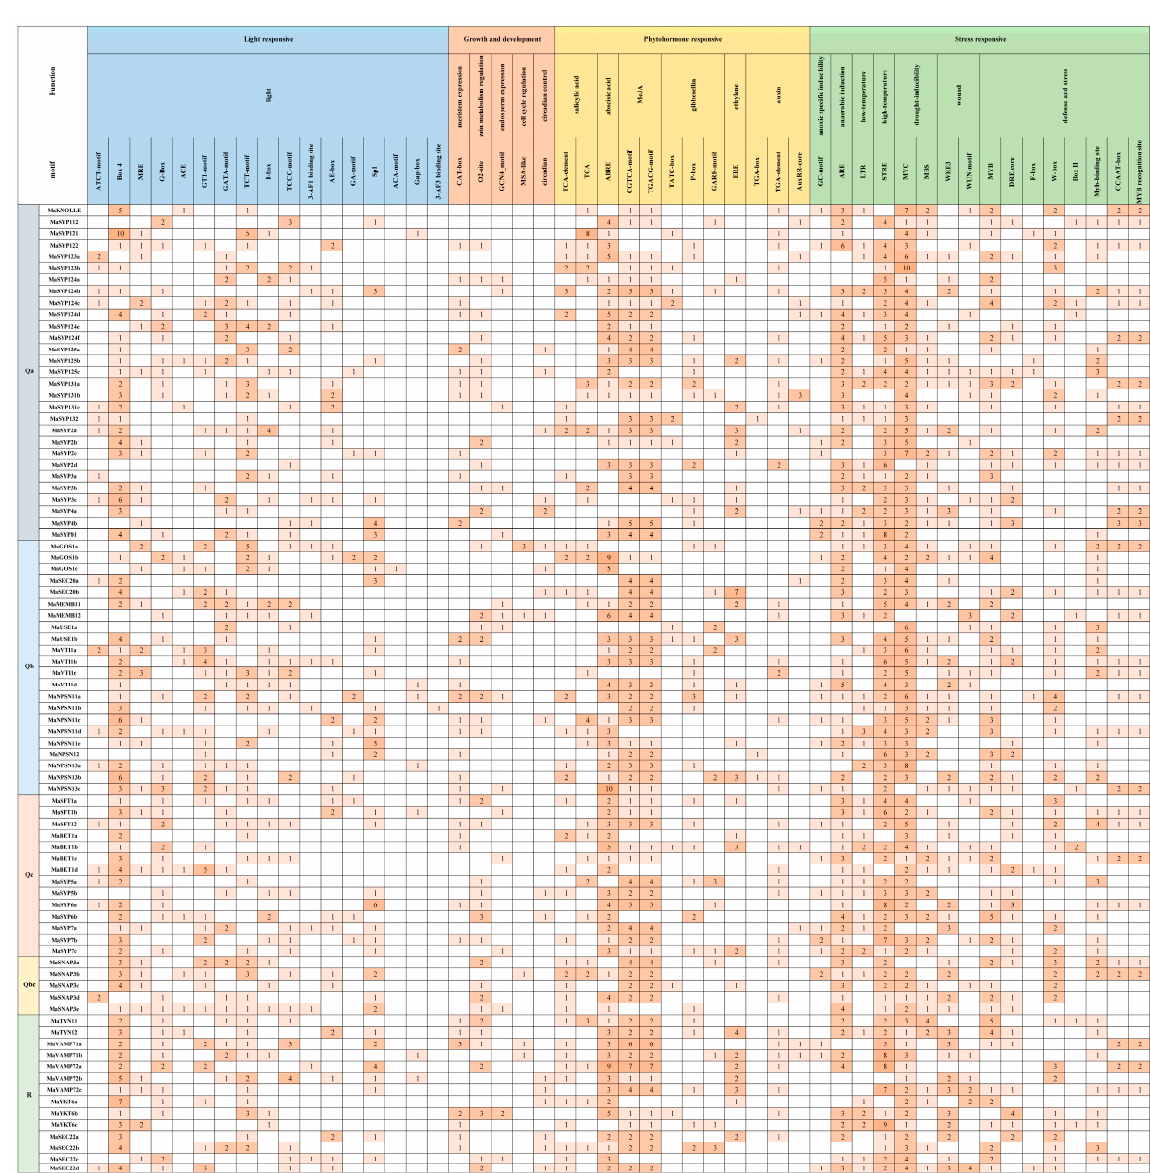
Figure 3. Predicted cis -acting elements in the promoters of MaSNARE genes. Qa, Qb, Qc, Qbc and R represent five SNARE subfamilies of banana. Cis -acting elements related to unknown functions were not